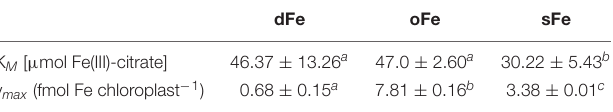
TABLE 2 | Parameters of the chloroplast Fe uptake activity calculated as Boltzmann sigmoidal fit on Fe acquisition activity of chloroplasts in the function of substrate concentration.